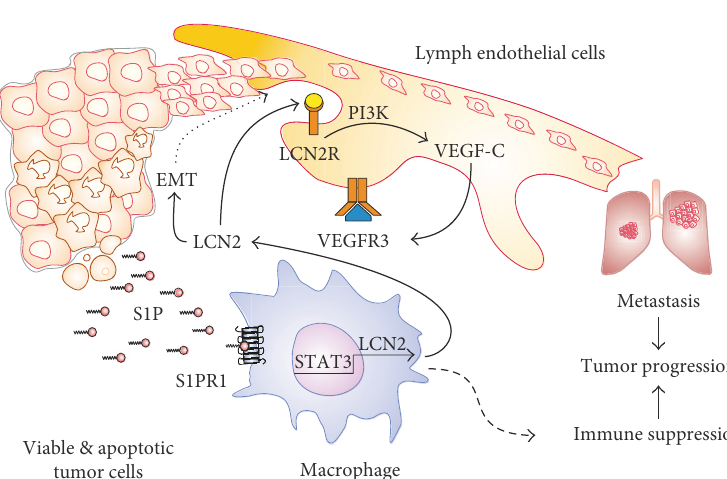
Figure 2: Macrophage-derived lipocalin-2 and lymphangiogenesis. Viable and apoptotic tumor cells produce S1P to stimulate the S1PR1 on macrophages. Downstream of S1PR1: there is activation of STAT3 to induce LCN2 mRNA and protein expression. LCN2 promotes EMT and drives lymphangiogenesis by activating its speci fi c receptor, LCN2R, on lymph endothelial cells. The LCN2R activates PI3K, which adds to the production of VEGF-C, provoking a self-amplifying loop via VEGFR3. These signals promote metastasis and tumor progression. Macrophages add to immune suppression by distinct mechanisms. For details, see the